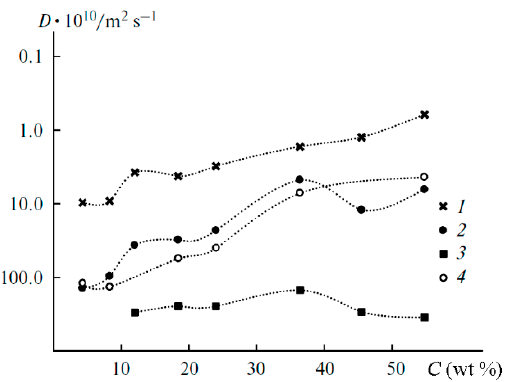
Figure 21. Dependences of the 1 H self-diffusion coefficients ( D ) on the solvent concentration ( C ) for the fast ( 1 ), medium ( 2 ), and slow ( 3 ) components; ( 4 ) is the same for lithium cations [54].